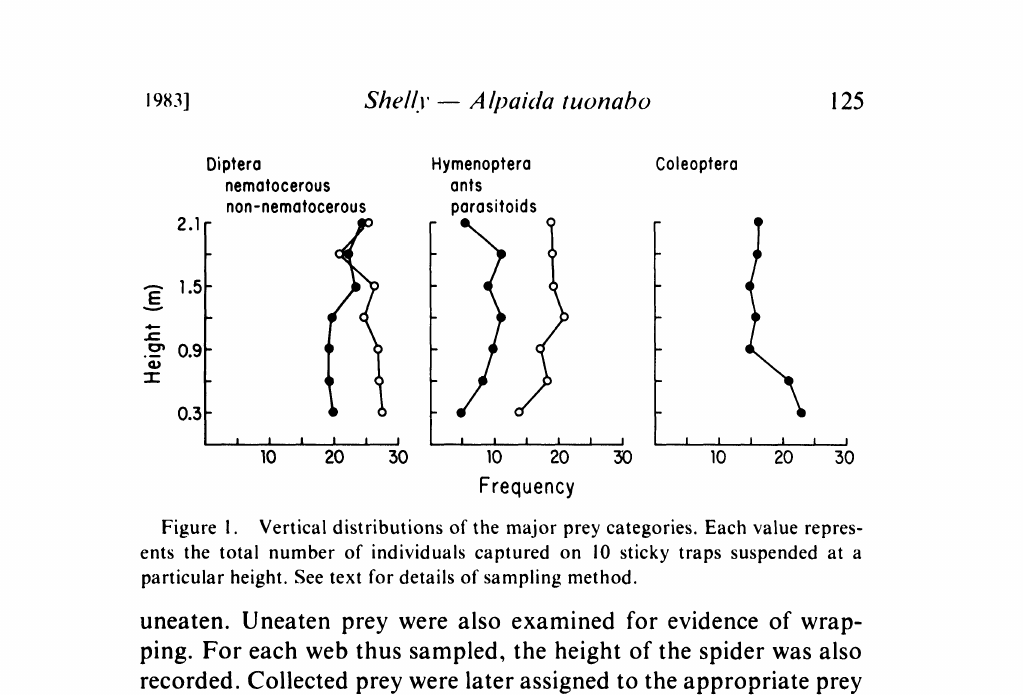
Figure I. Vertical distributions of the major prey categories. Each value repres- ents the total number of individuals captured on l0 sticky traps suspended at a particular height. See text for details of sampling